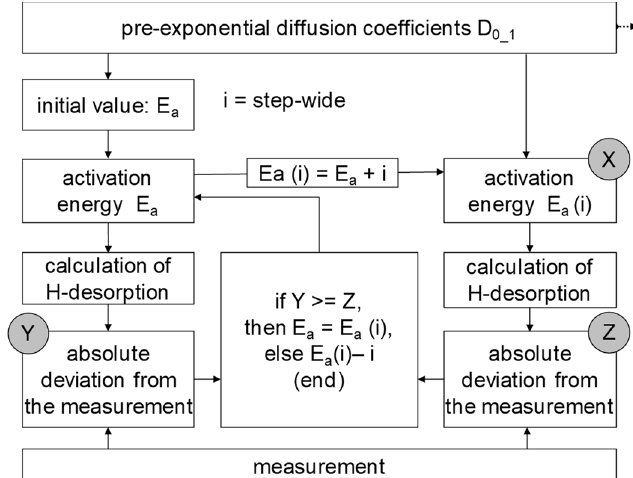
Figure 19. The procedure of the iteration.